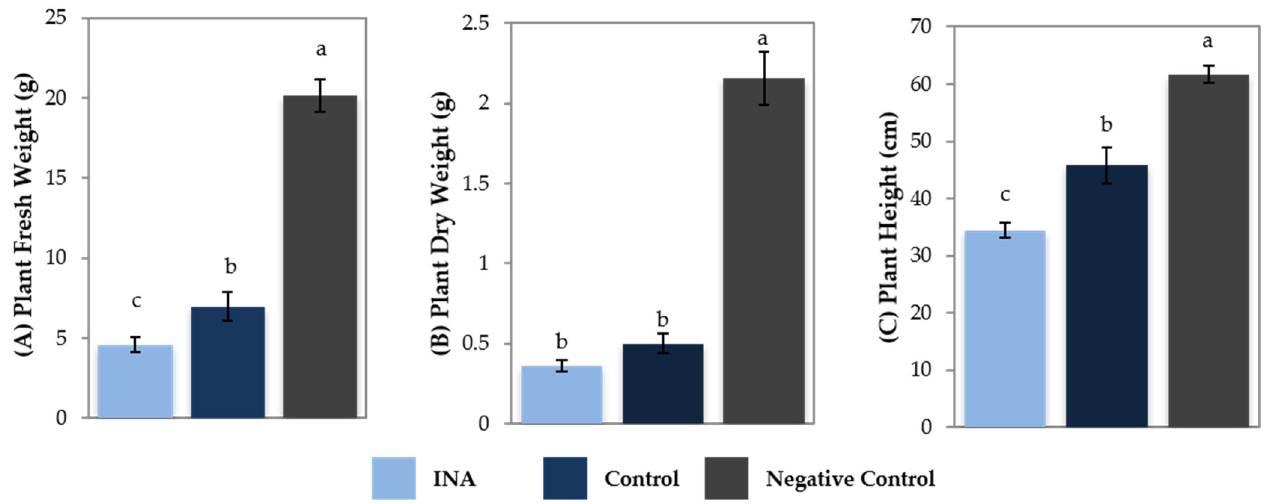
Figure 3. The effects of 2,6-dichloroisonicotinic acid (INA) on ( A ) plant fresh weight, ( B ) plant dry weight, and ( C ) plant height on A. solani -infected or -uninfected (negative control) tomato plants. Columns with different letters are significantly different according to the LSD test ( p < 0.05).